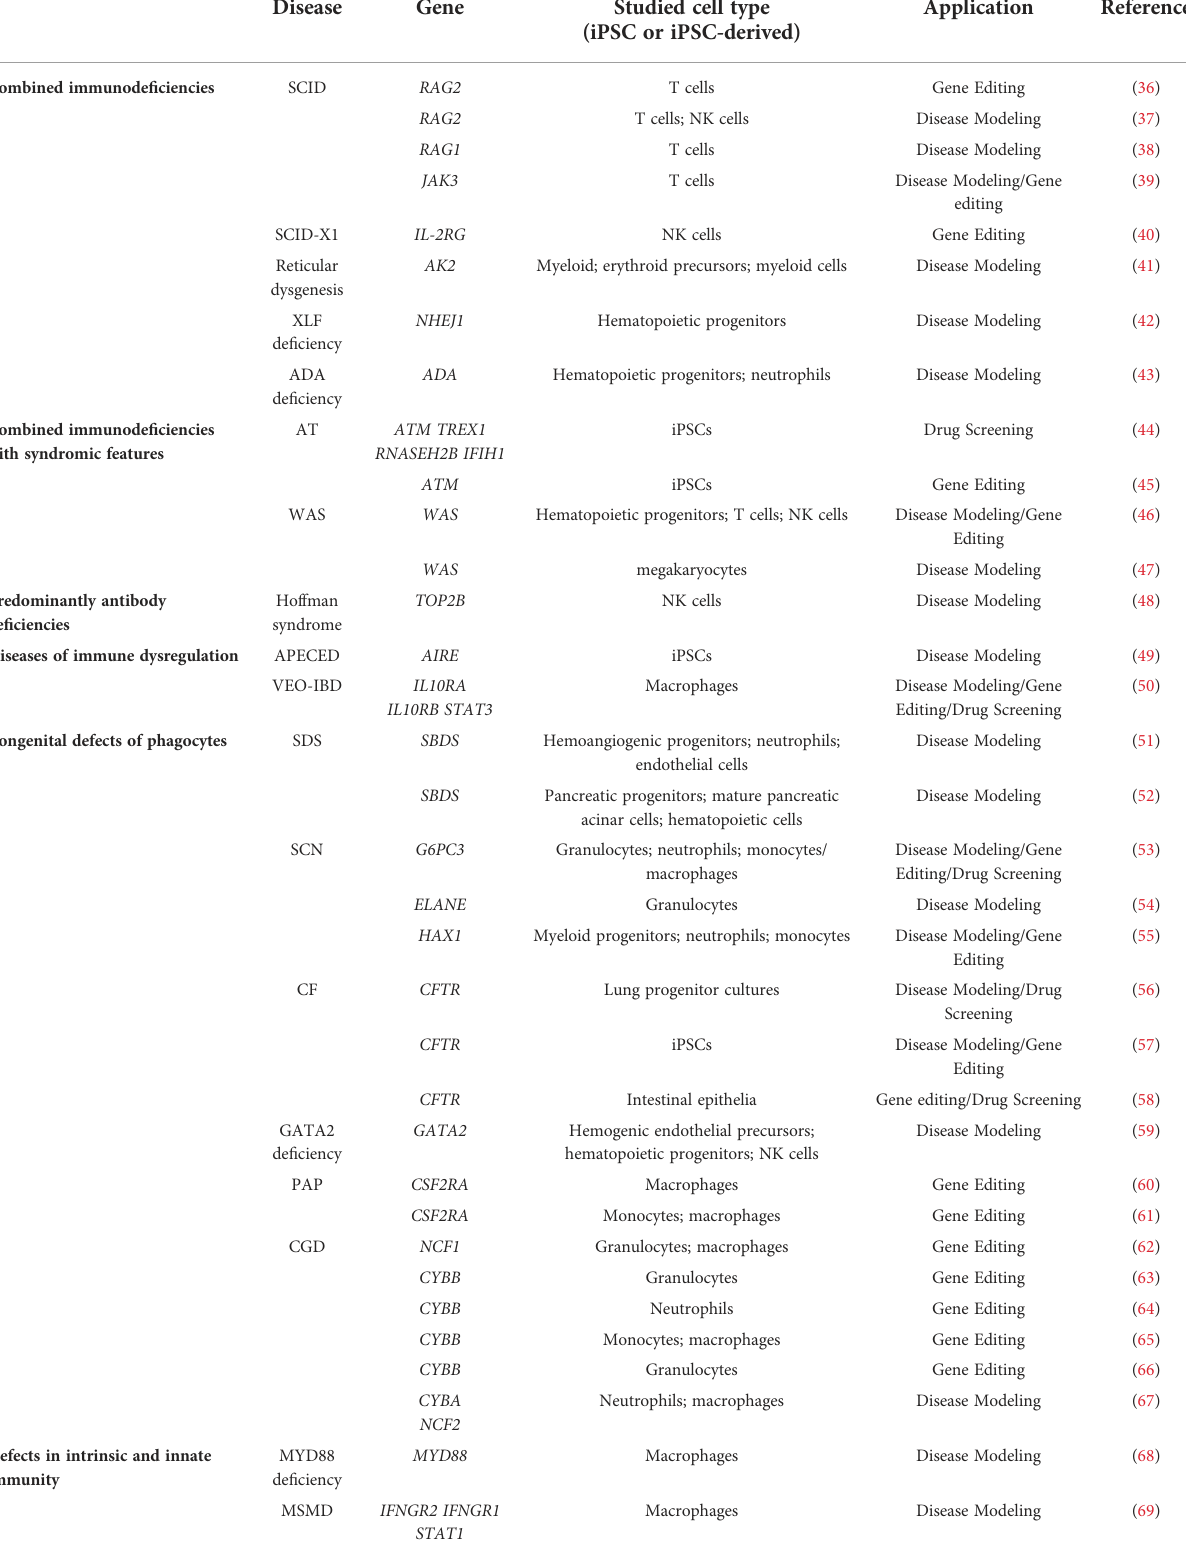
TABLE 1 An overview of the latest studies using iPSC-derived cells to study